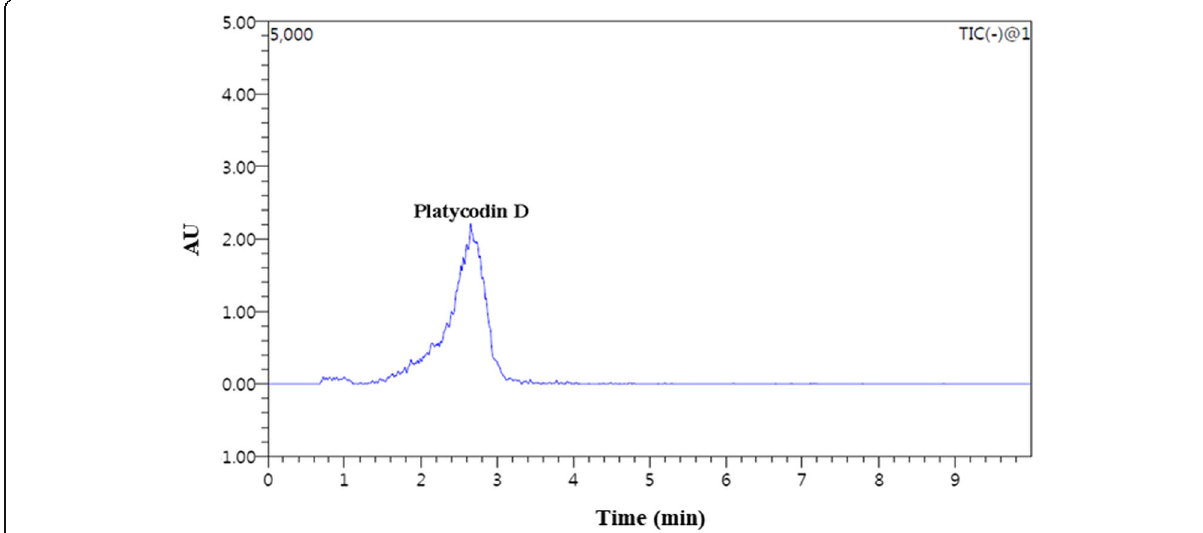
Fig. 1 Representative high-performance liquid chromatography profile of PGE. Platycodin D was detected by LC-MS/MS